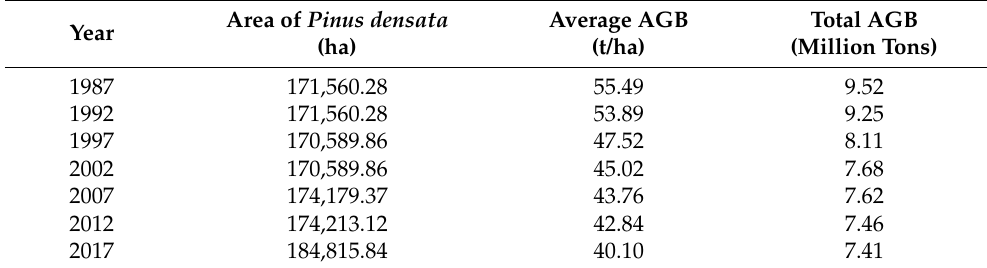
Table 4. Results of estimation of AGB of Pinus densata by years. Area of Pinus densata Year